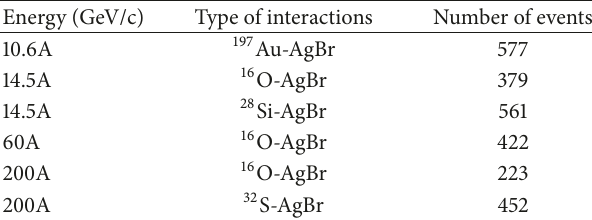
Table 1: Number of events selected for the